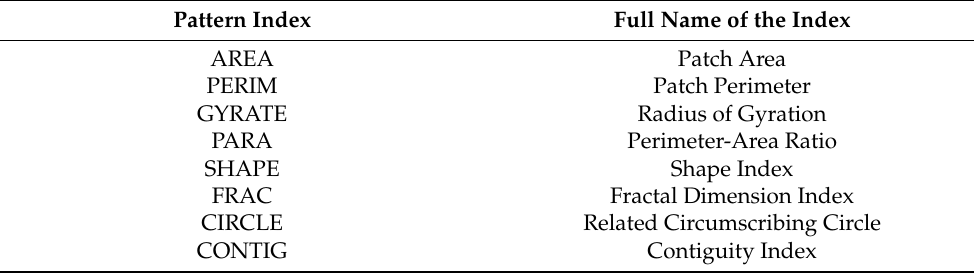
Table 2. Pattern index and its